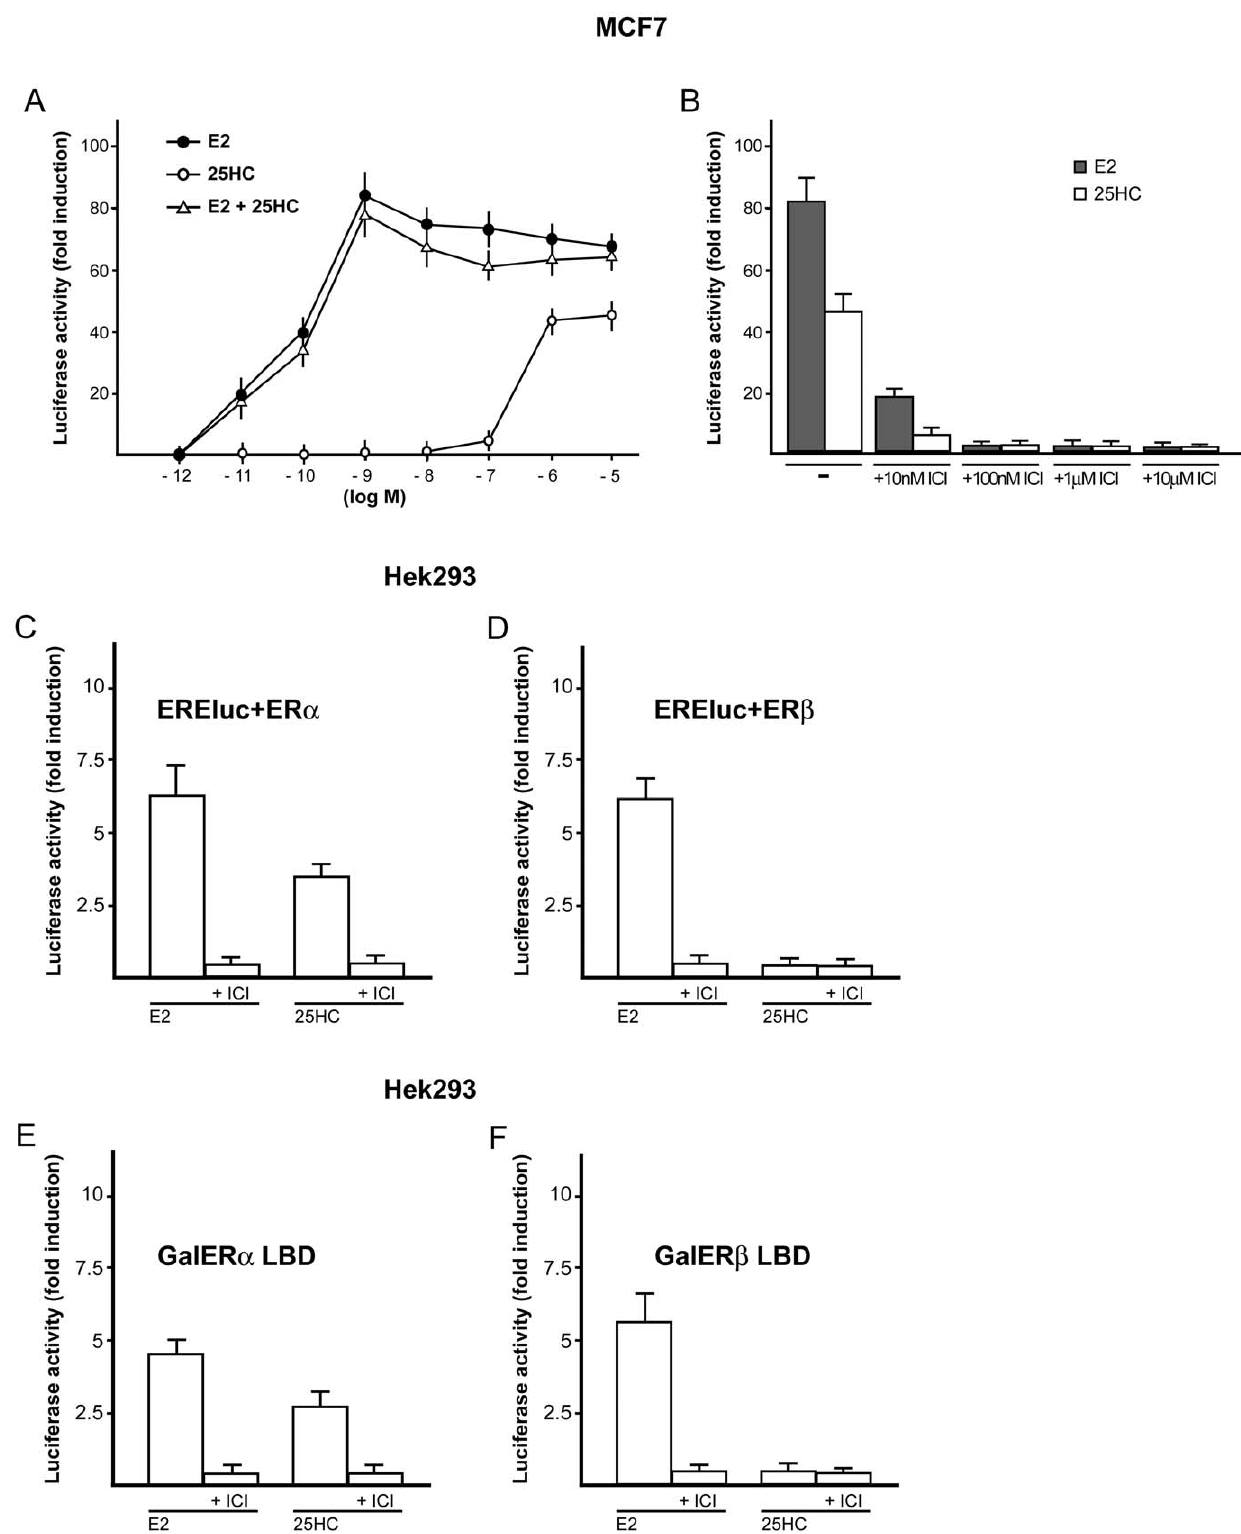
Figure 1. 25HC activates ER a . (A) MCF7 cells were transfected with an ER luciferase reporter gene along with the internal transfection control Renilla Luciferase and treated with increasing concentrations (logarithmic scale) of E2 and 25HC. Moreover, cells were treated simultaneously with similar doses of each compound. The normalized luciferase activity values of cells treated with vehicle (-) were set as 1-fold induction, upon which the activity induced by treatments was calculated. (B) MCF7 cells transfected with the ER reporter gene were treated with 10nM E2 or 1 m M 25HC alone and in combination with increasing concentration of the ER antagonist ICI, as indicated. Each data point represents the mean 6 SD of three